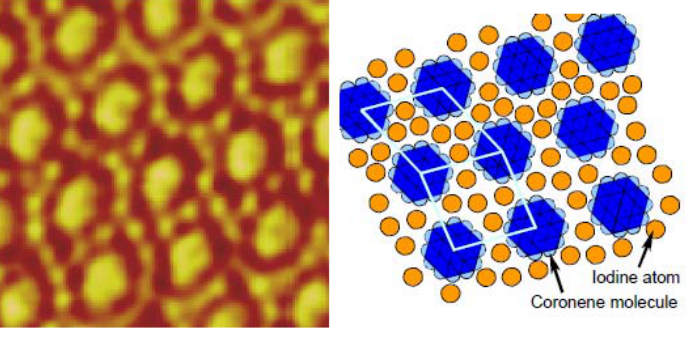
Figure 8. STM image and tentative model of coronene and iodine co-adsorption at the aqueous solution–Au(111) interface under the electrochemical potential control. Reproduced from reference [40] by permission ECS ― The Electrochemical